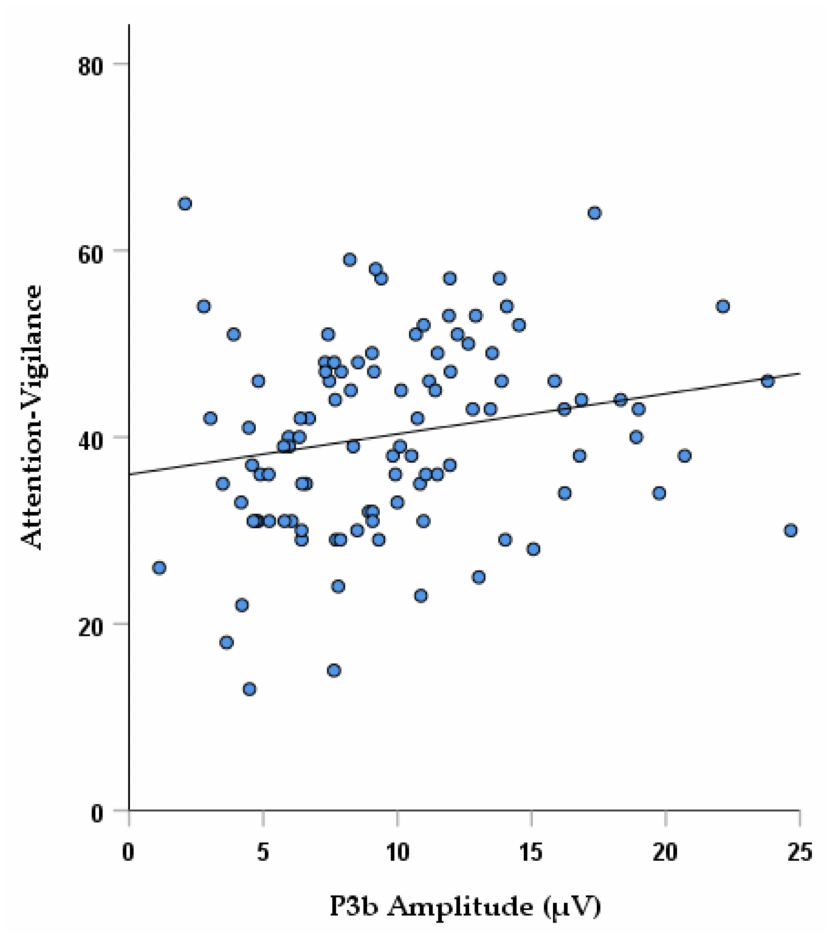
Figure 2. Correlation between P3b amplitude and attention-vigilance domain scores in SCZ. In HCs, neither of the two P3b parameters was associated with the six cognitive do- mains considered. However, age was negatively correlated with P3b amplitude ( r s = − 0.470; p = 0.00010), and positively with P3b latency ( r s = − 0.309; p = 0.014) (Table